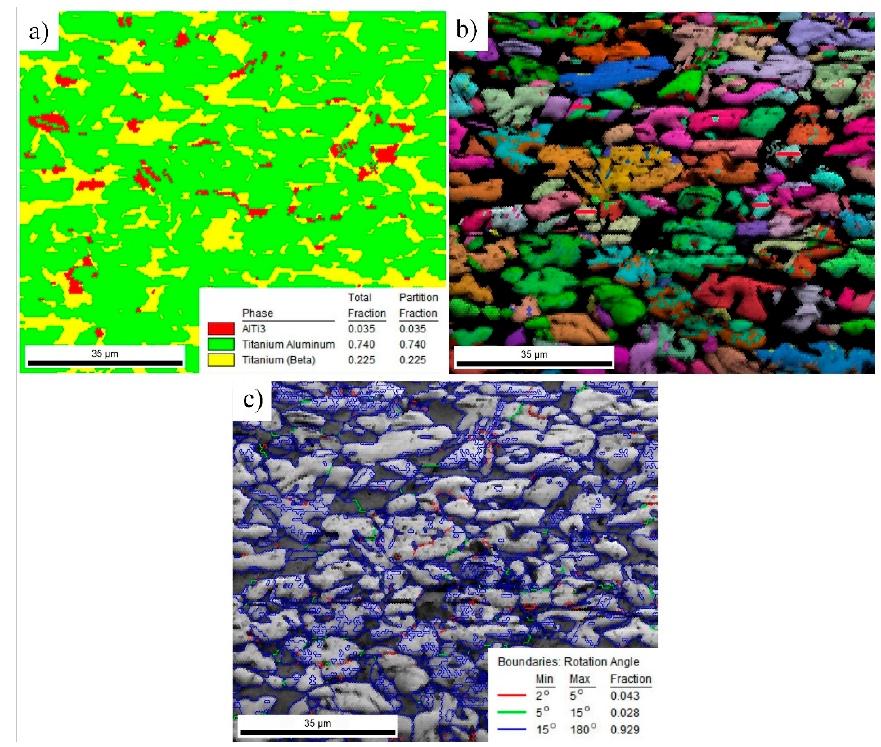
Figure 4. EBSD images showing the microstructure in the center of the forging stock. ( a ) Constituent phase; ( b ) inverse pole figure; ( c ) grain boundary.